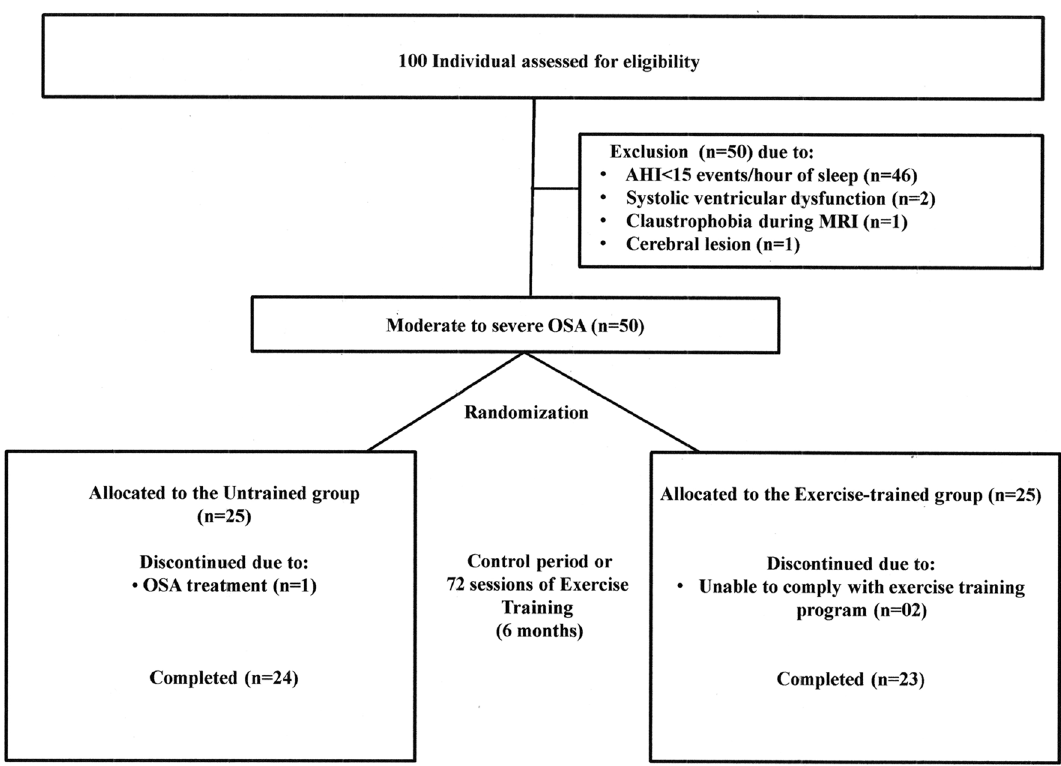
Figure 1. Profile of a randomized clinical trial showing the progress of patients throughout the trial. AHI , apnea–hypopnea index; MRI , magnetic resonance image; OSA , obstructive sleep